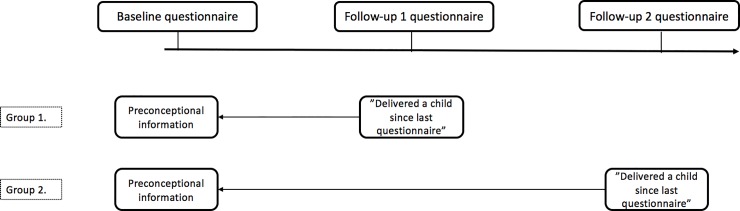
Overview Lifelines participants.